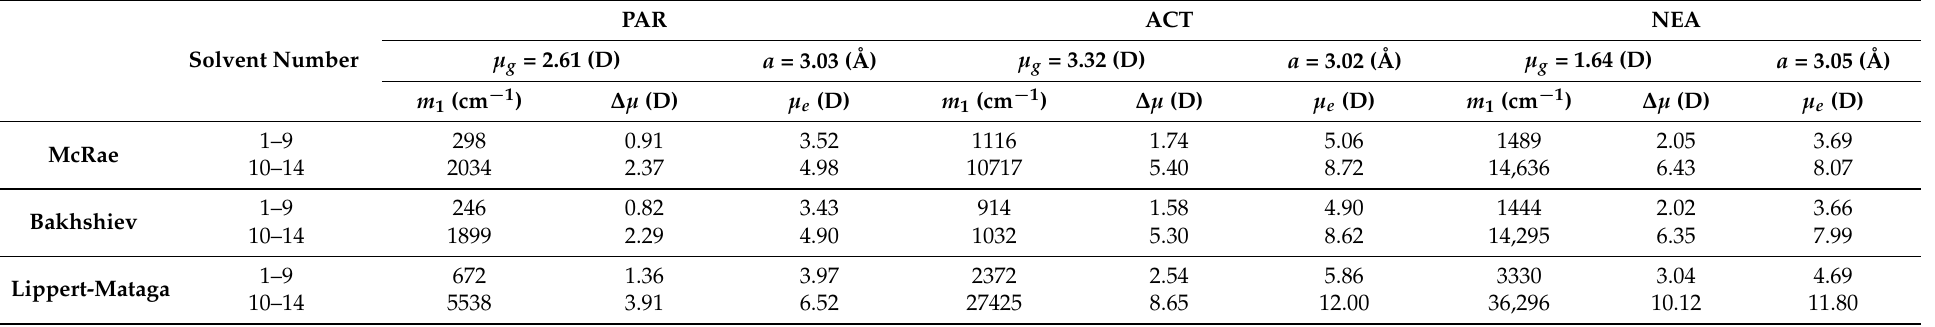
Table 2. The theoretically calculated ground state dipole moments ( µ g (D)) and Onsager’s radius values ( a (Å)), as well as the values of m 1 , difference in the excited and ground state dipole moments ∆ µ (D), and excited state dipole moment µ e (D) of the investigated molecules obtained using McRae’s, Bakhshiev’s, and Lippert-Mataga’s models.